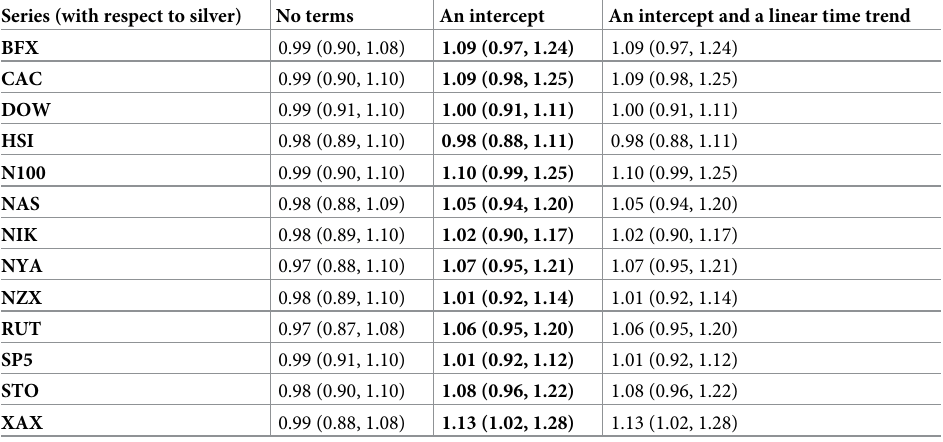
Table 4. Estimates of d for the SILVER differential. Sample ending in June